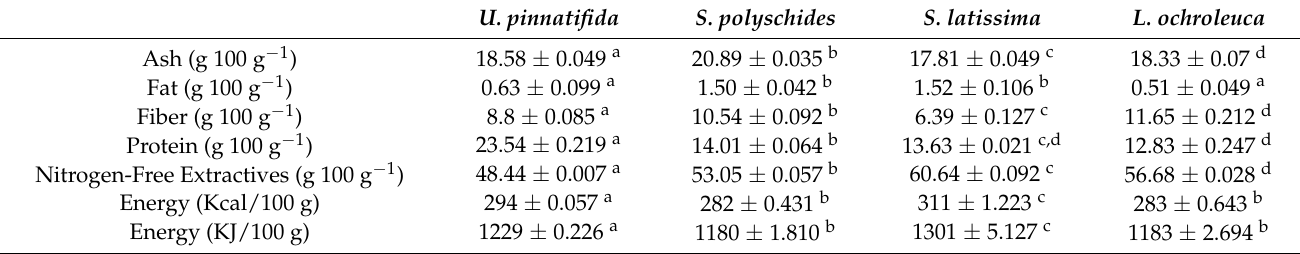
Table 3. Nutritional characterization of the dried biomass of U. pinnatifida , S. latissima , L. ochroleuca , and S. polyschides . Results are expressed in mean ± standard error ( n = 2; dry weight basis). Statistically significant differences in the same element content among the species are expressed by different